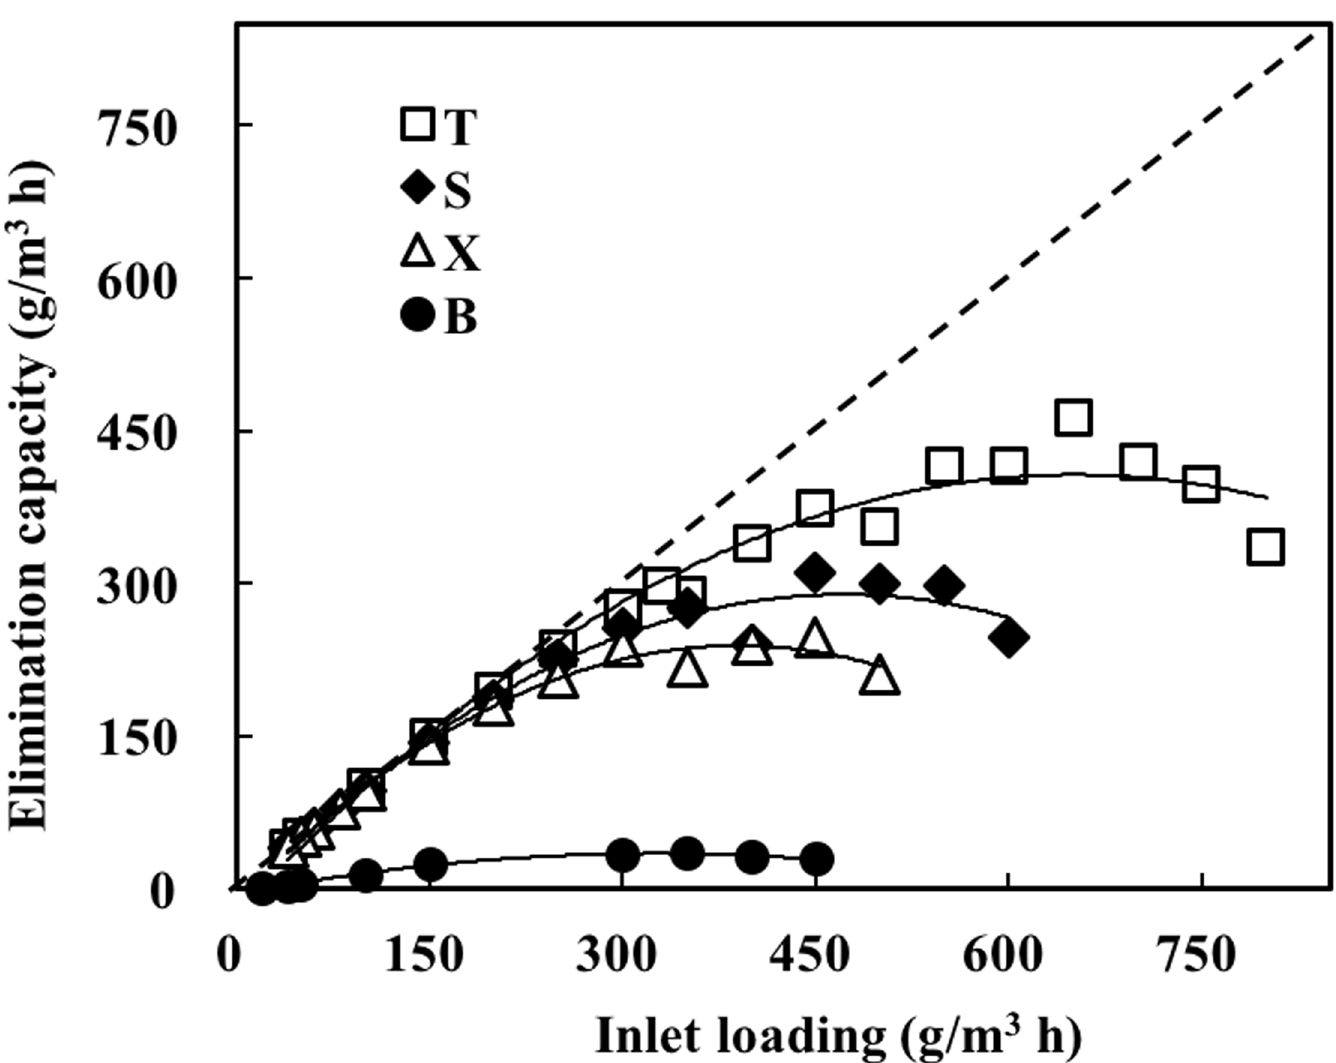
Fig 2. Elimination capacities of single toluene, styrene, xylene and benzene with inlet loadings. B: benzene; T: toluene; X: xylene; S: